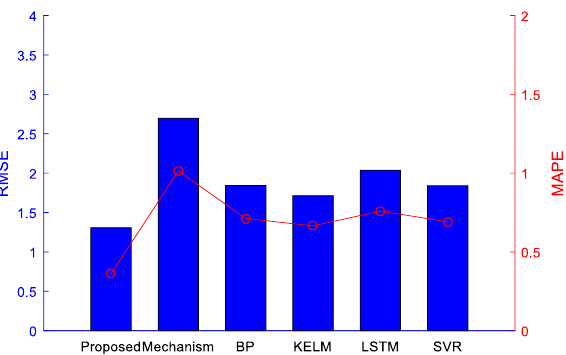
Figure 10. Results for different prediction models, including RMSE and MAPE values when the data fluctuate smoothly.